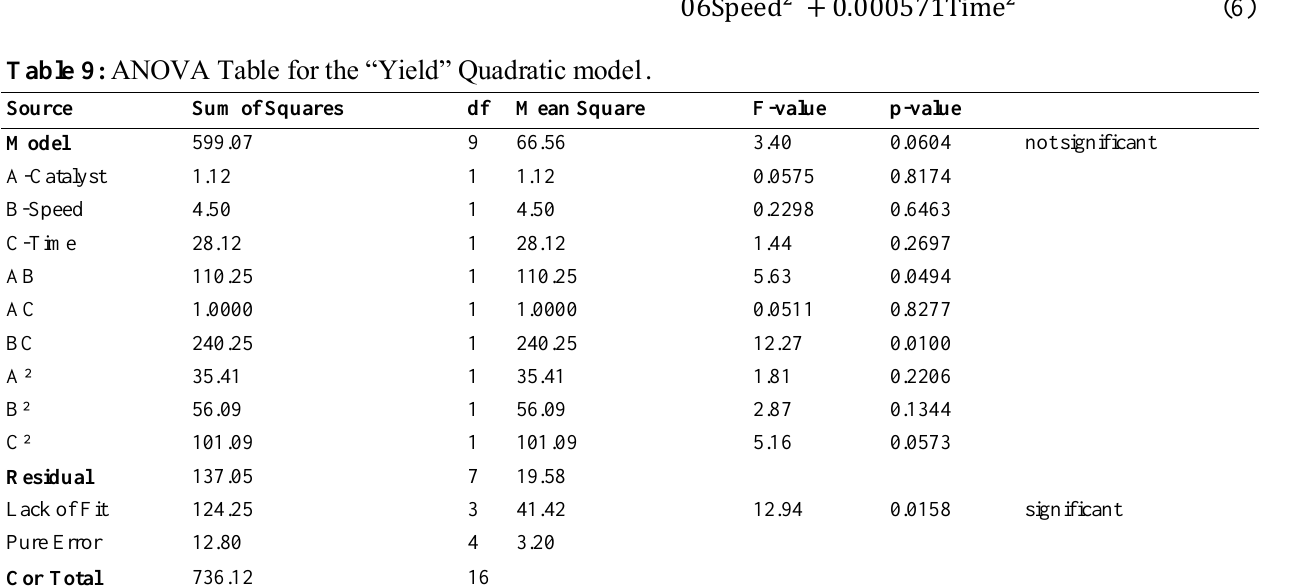
Table 9: ANOVA Table for the “Yield” Quadratic